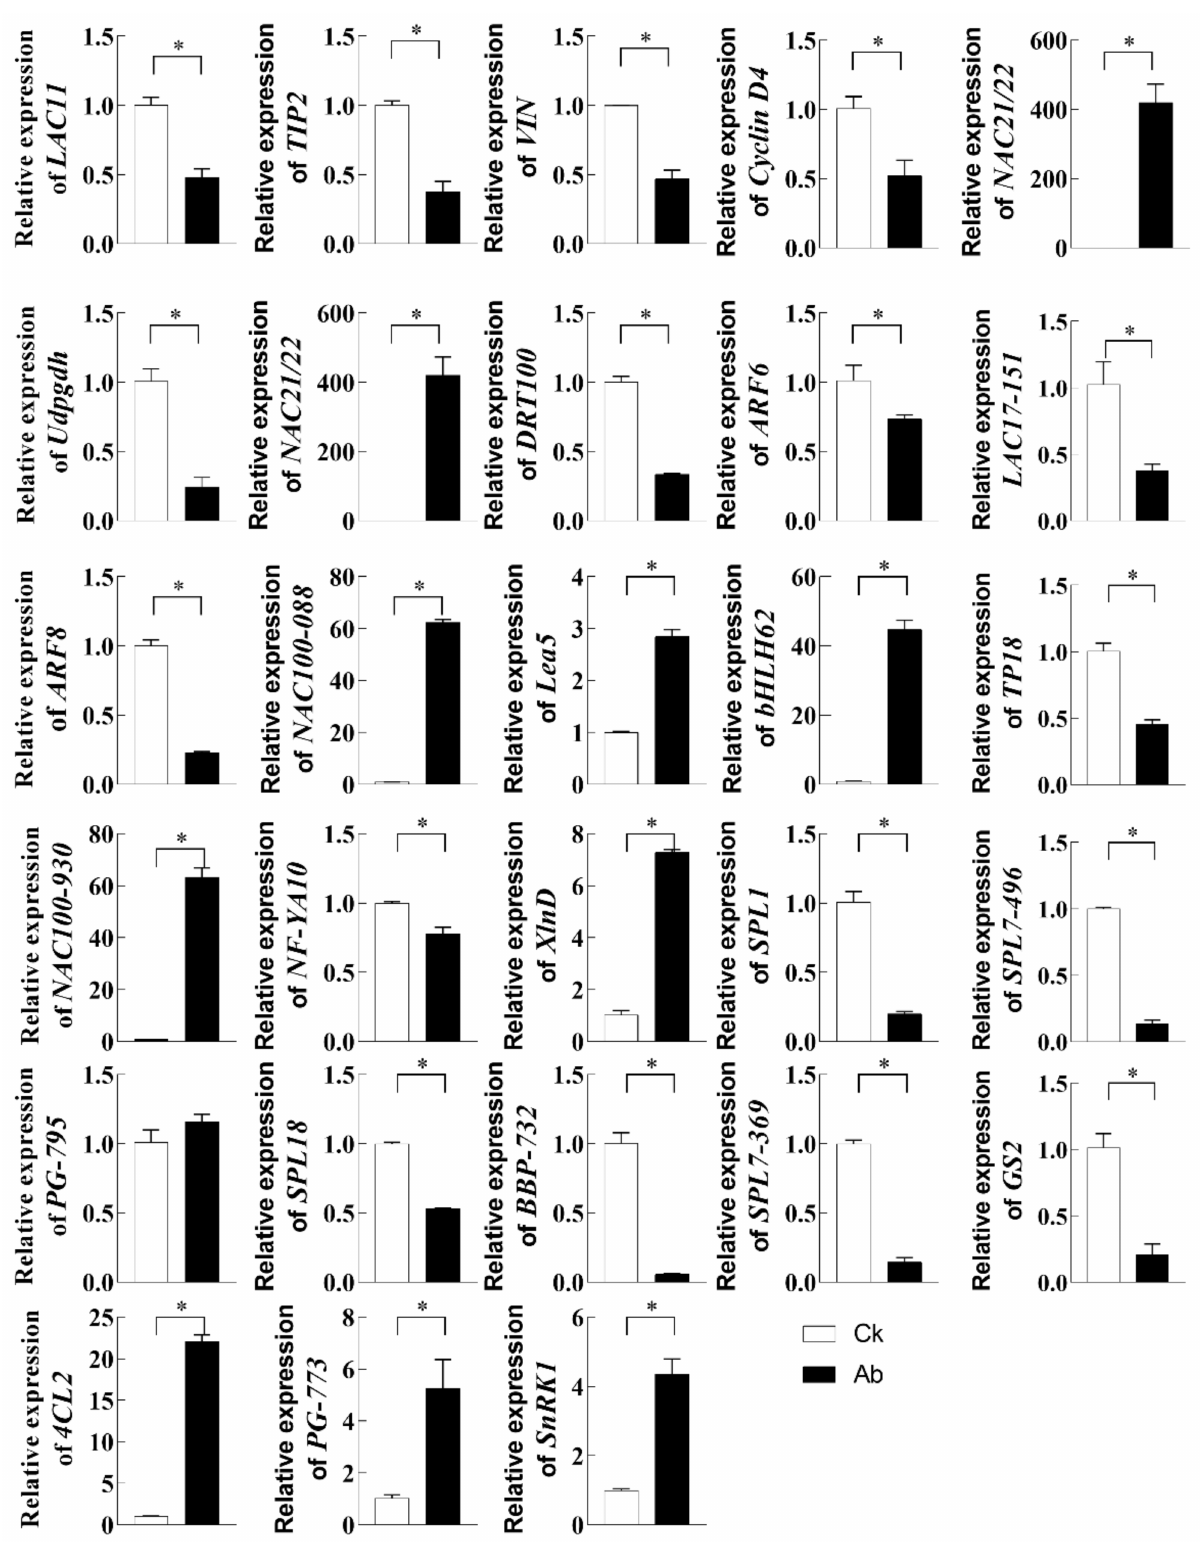
Figure 4. Relative expression level of 28 genes by RT-qPCR analysis. Normal (Ck) and aborting lotus flower buds (Ab) (2–3 cm in length) were collected for RT-qPCR analysis. Values are the means ± SE of three independent experiments with at least three replicates for each. Asterisks indicate that mean values are significantly different in comparison with Ck at p < 0.05 according to a t -test. NnActin (XM_010252745) were used for cDNA normalization. Udpgdh: UDP-glucose 6-dehydrogenase 5-like (LOC104598792); Cyclin-D6: Putative cyclin-D6-1 (LOC104605722); VIN: